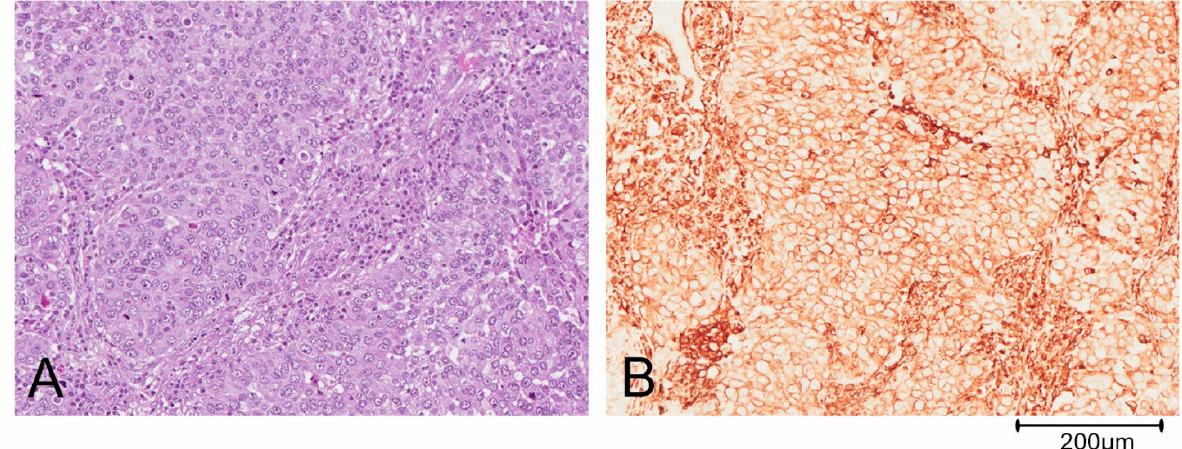
Figure 1. Metaplastic breast carcinoma. ( A ) Tumor cells are highly pleomorphic and arranged in solid nests. ( B ) Immunohistochemistry shows a diffuse positivity of neoplastic cells for the mesenchymal marker vimentin.